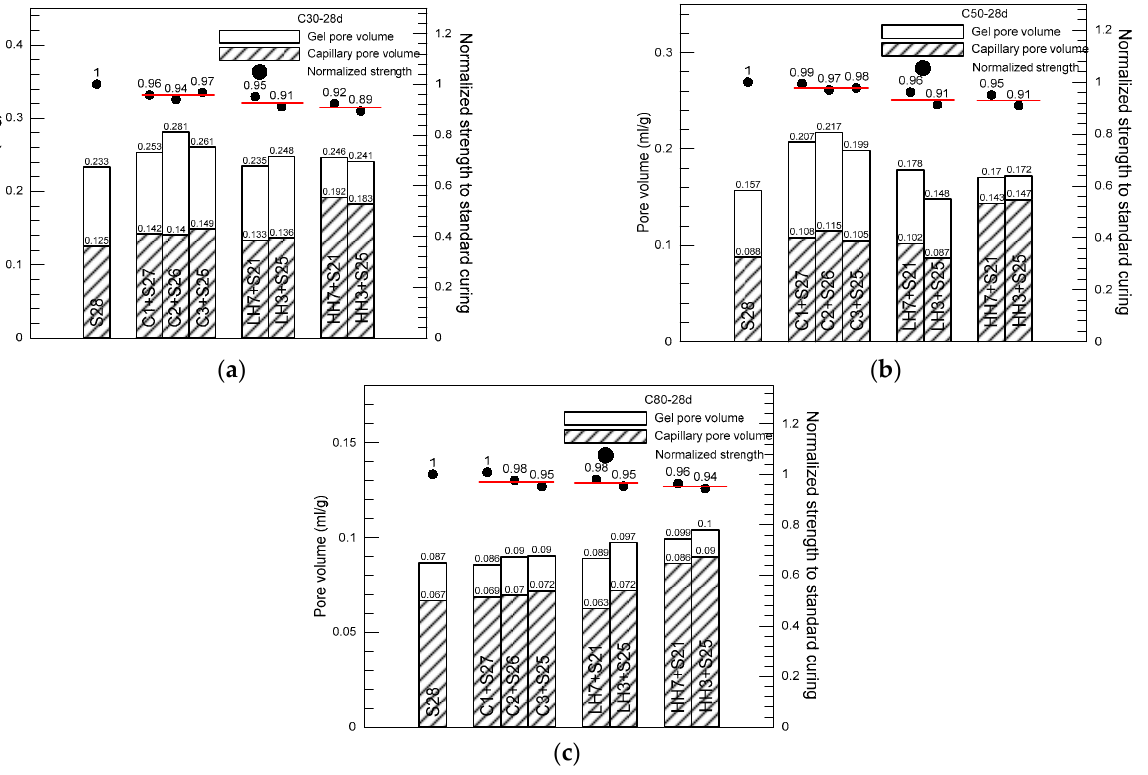
Figure 8. Total, capillary and gel pore volume of the paste of C30 ( a ), C50 ( b ) and C80 ( c ) concrete at 28 days with effect of curing procedure, along with the corresponding normalized strength.